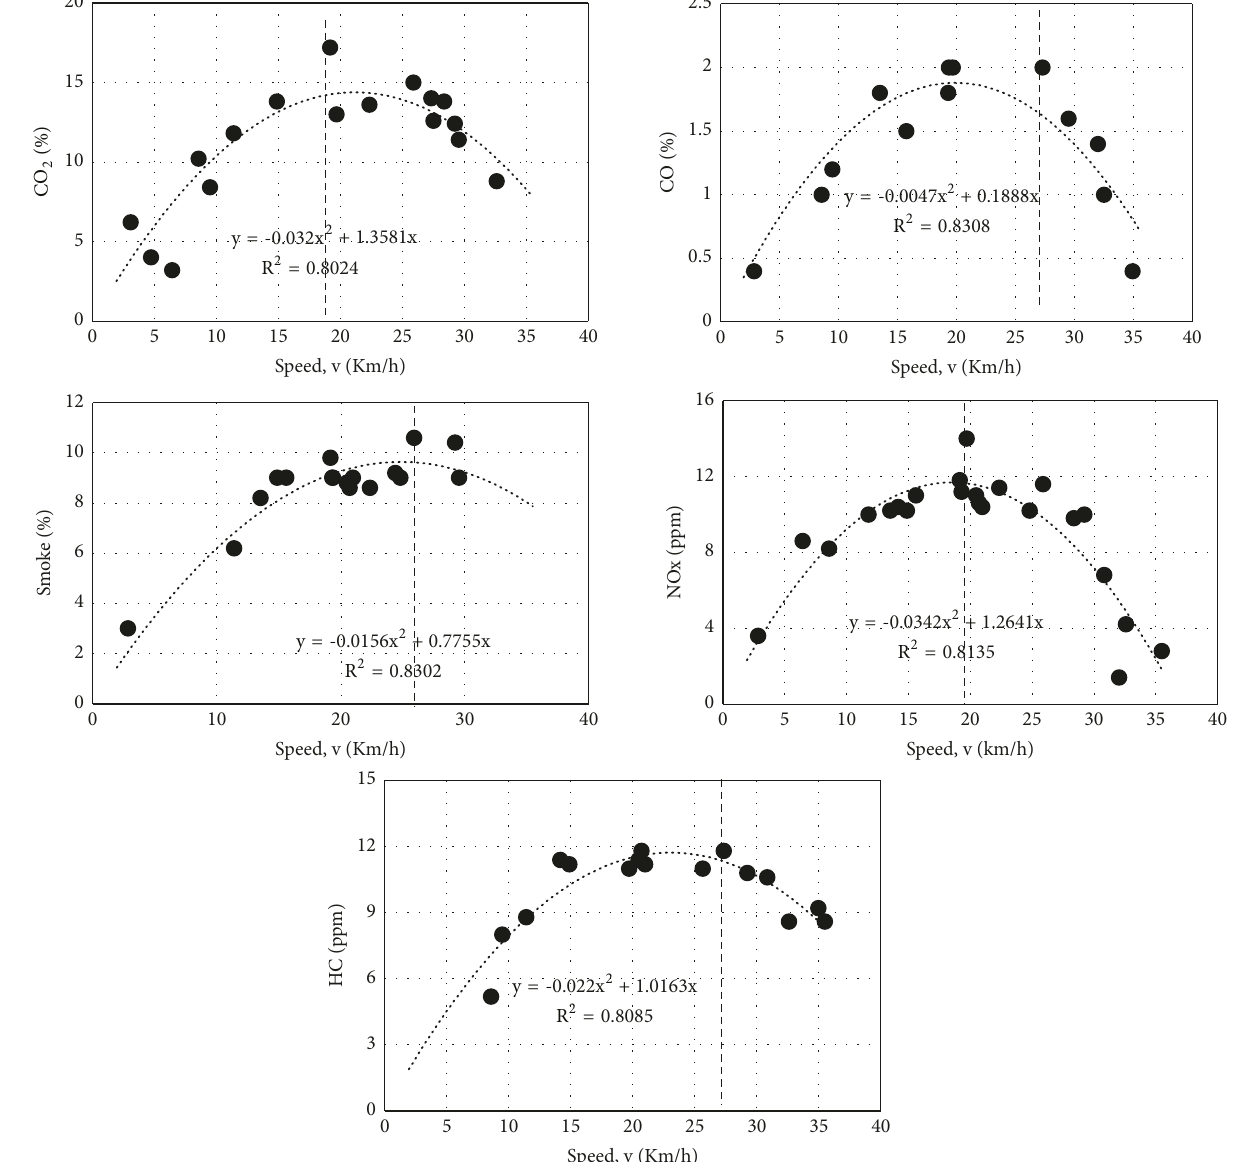
Figure 6: Exhaust emission driving cycle pattern of truck on damaged road